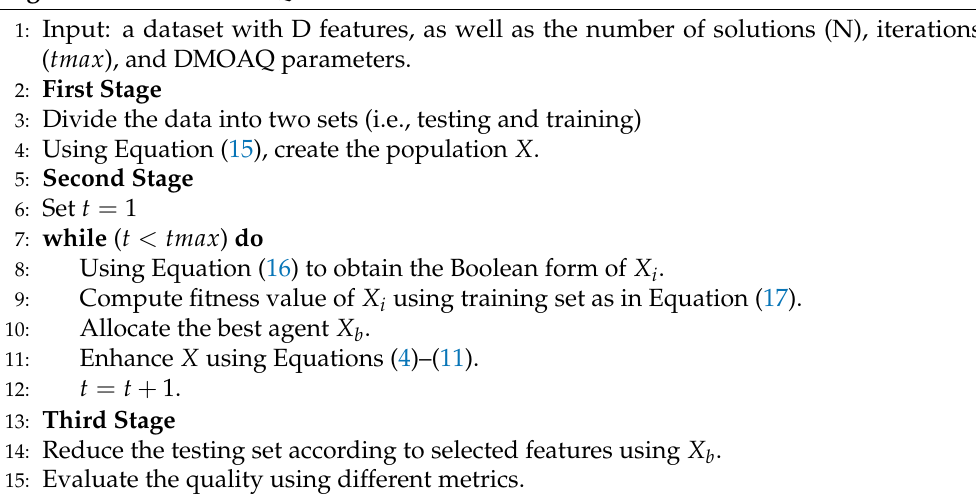
Algorithm 1 The DMOAQ